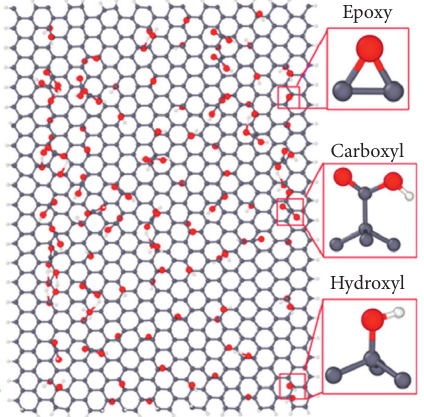
Figure 1: Atomic configuration diagram of